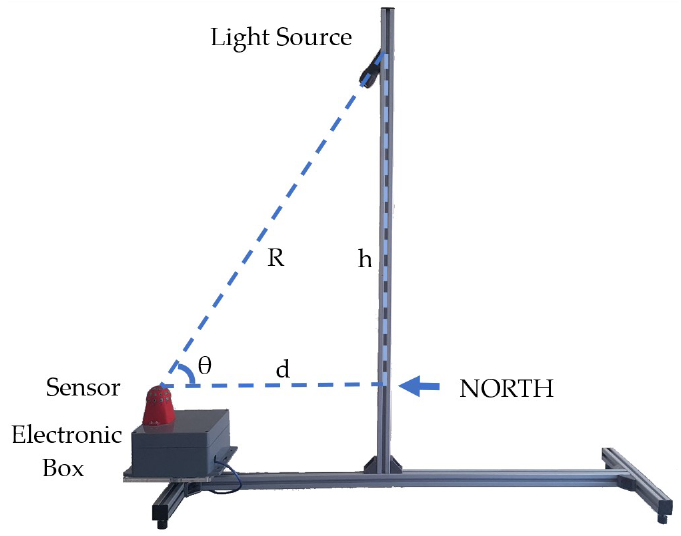
Figure 7. Experimental Setup for the novel sensor test .